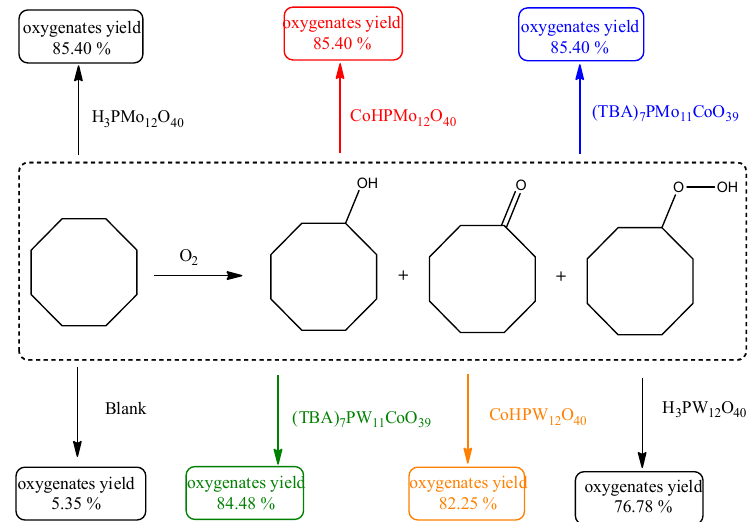
Scheme 12. Oxidation of cyclooctane with molecular oxygen in the presence of phosphotungstic or phosphomolybdic acids or their cobalt salts (adapted from ref. [41]).